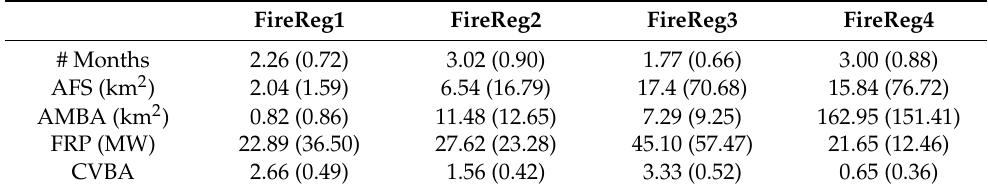
Table 2. Mean value of each attribute for each identified fire regime. The standard deviation of the variables is shown in brackets.